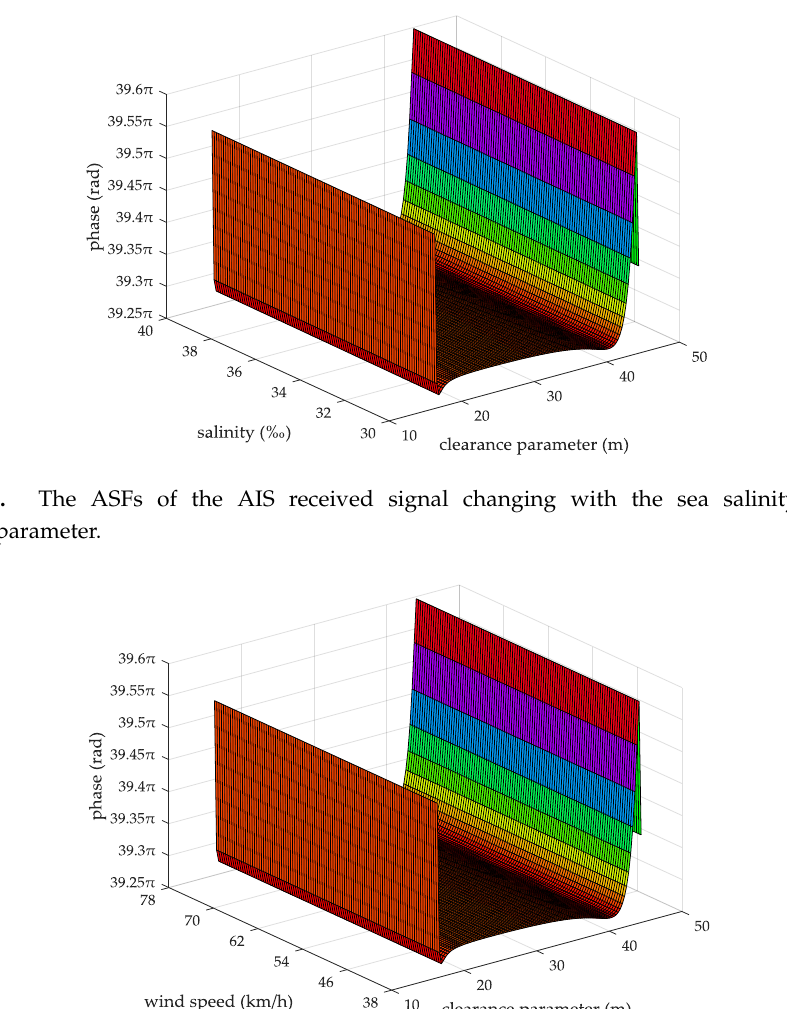
Figure 13. The ASFs of the AIS received signal changing with the wave heights and the clearance parameters. From the information in Figure 13, when the seawater temperature is 28 °C, the sea salinity is 32.54‰, the propagation distance is 10 nautical miles, the wind speed is 54 km/h, within the wave height is 2–7 m, the clearance parameter is 13–46.38 m and the ASFs of the AIS received signal is 39.2– 39.53π. In this case, the range positioning error corrections of the AIS signal is 3.63–3.66 m. Thus, it